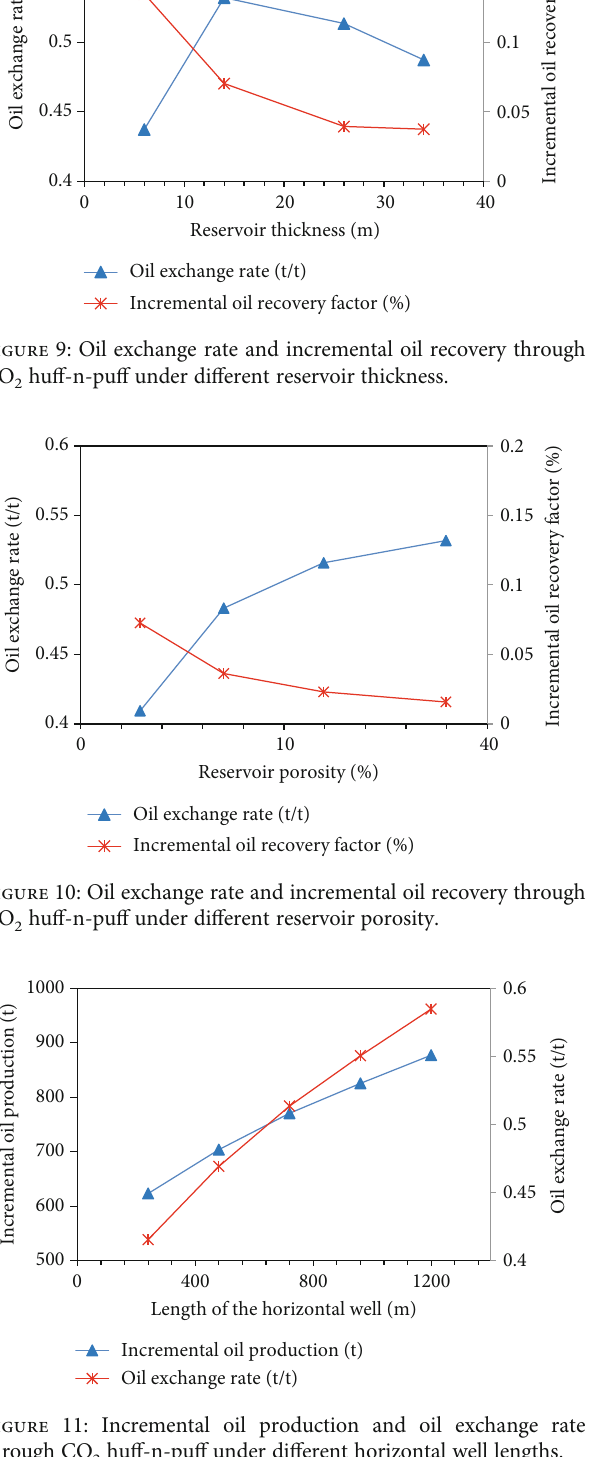
Figure 14: Incremental oil production and oil exchange rate through CO hu ff -n-pu ff under di ff erent fracture 2